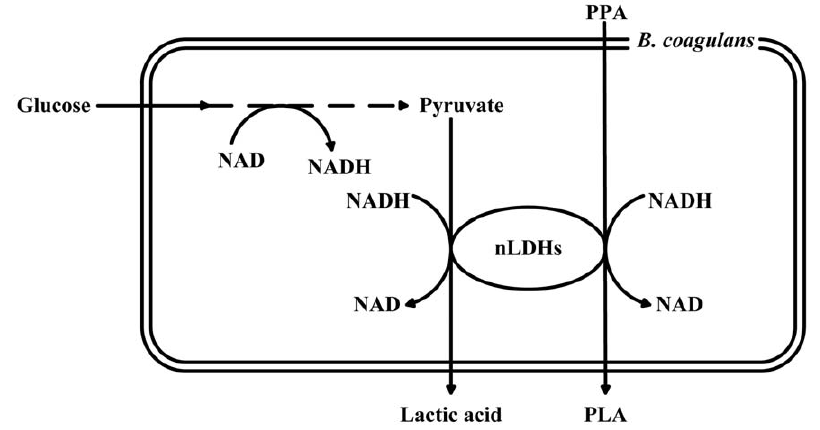
Figure 4. Schematic view of PLA production system of B.coagulans SDM. doi:10.1371/journal.pone.0019030.g004 PLoS ONE |